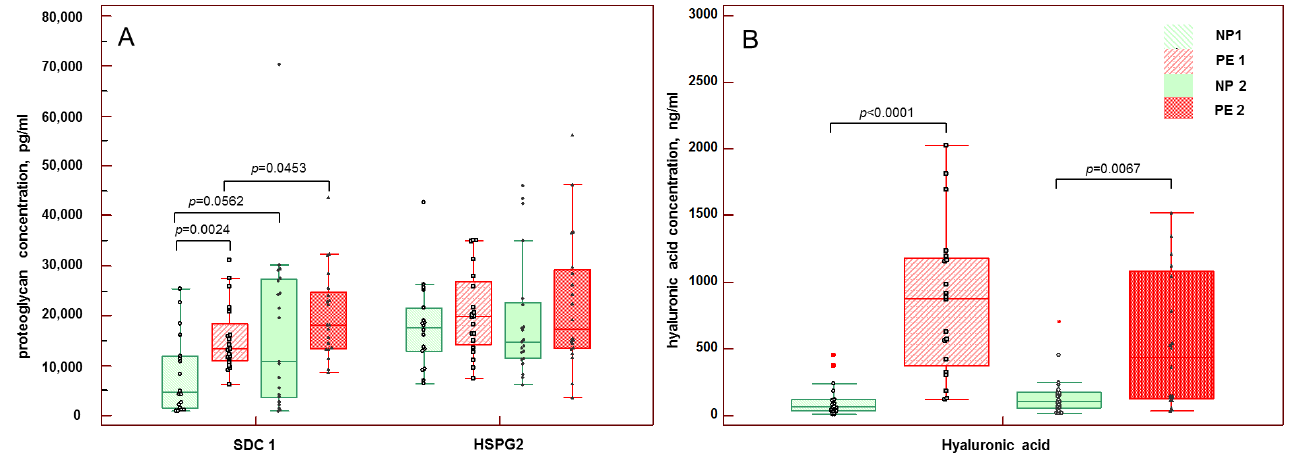
Figure 1. Serum concentrations of syndecan-1 (SDC1), heparin sulfate proteoglycan-2 (HSPG2) ( A ) and hyaluronic acid ( B ) in patients with early-onset PE, late-onset PE and in normotensive women.